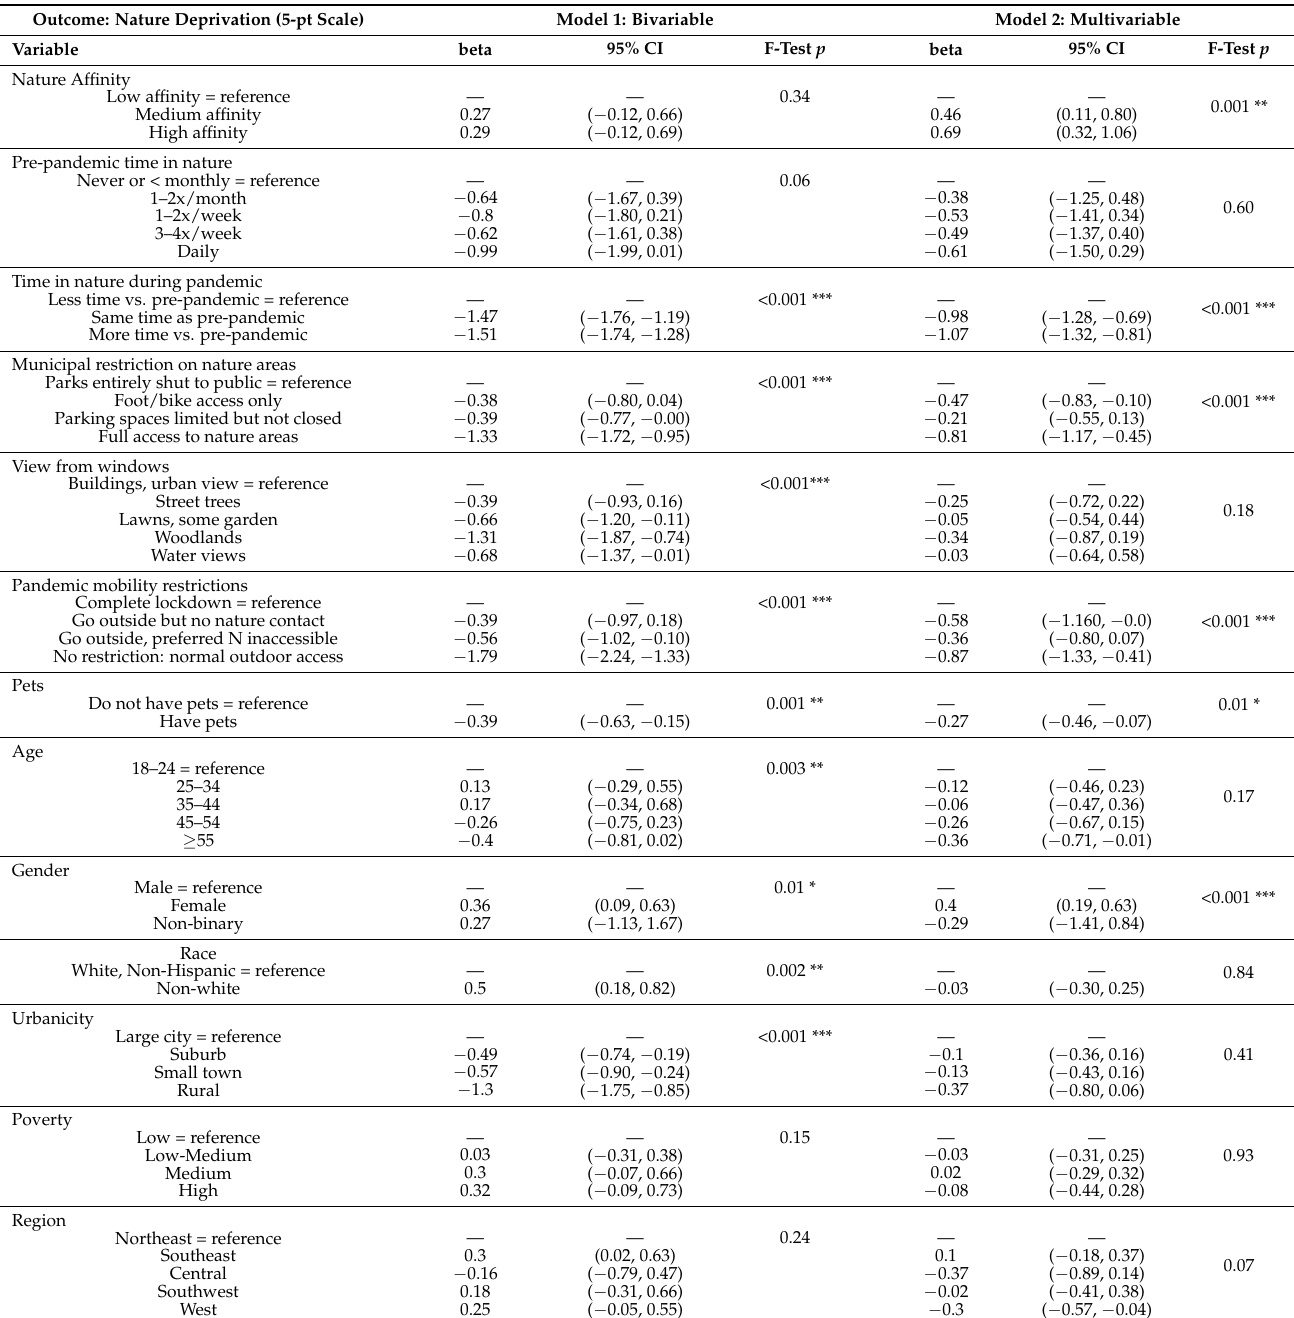
Table 2. Linear regression analysis illustrating effect of bivariable predictors and fully-adjusted multivariable model of nature deprivation under COVID-19 lockdown restrictions.